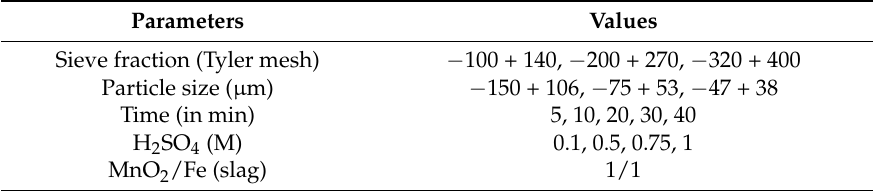
Table 5. Experimental conditions for the study of the effect of manganese nodule particle size.